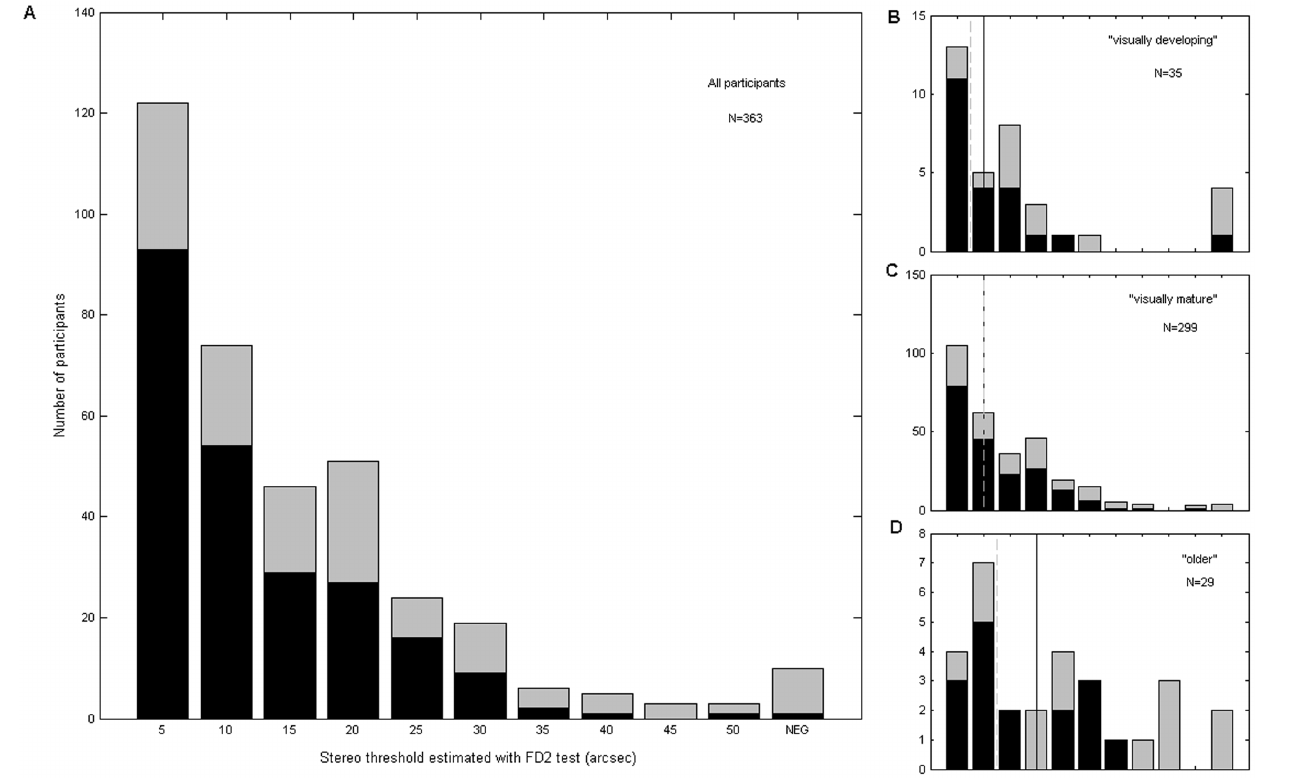
Figure 3. Frequency histogram of stereo thresholds estimated with the FD2 test. Other details as for Figure 2.